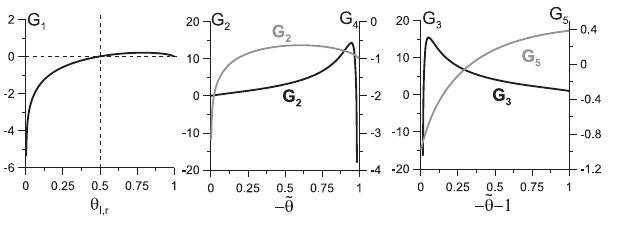
Fig. A2. Functions G i with i = 1 ... 5.